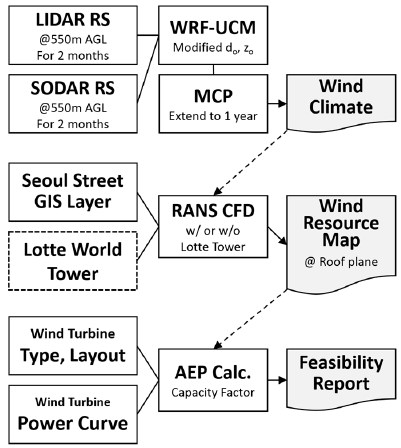
Figure 5. Procedure of wind resource assessment for a high-rise BIWT by using RS–NWP–CFD.